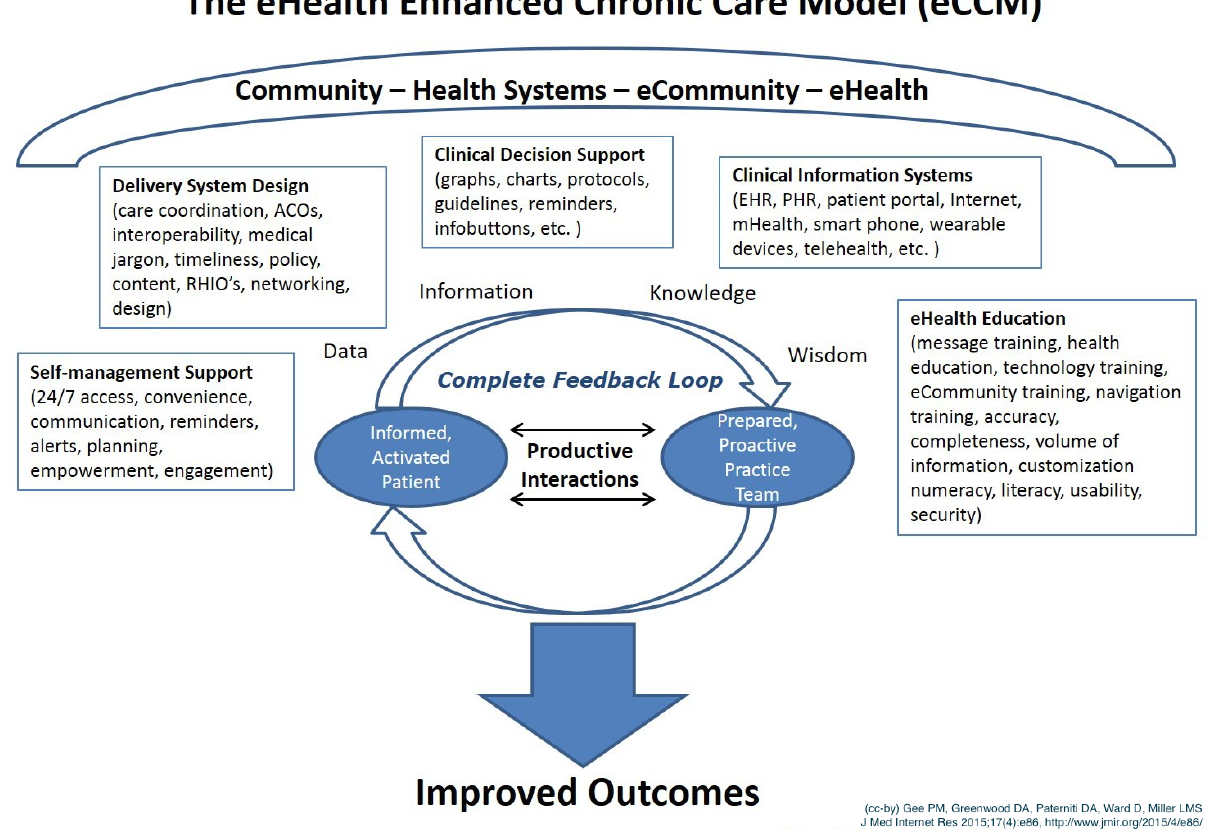
Figure 2. The eHealth Enhanced Chronic Care Model. Created by Gee, P M; Greenwood, D A; Paterniti, D A; Ward, D; and Miller, L M S (JMIR, 2015). Adapted from The Chronic Care Model (see Figure